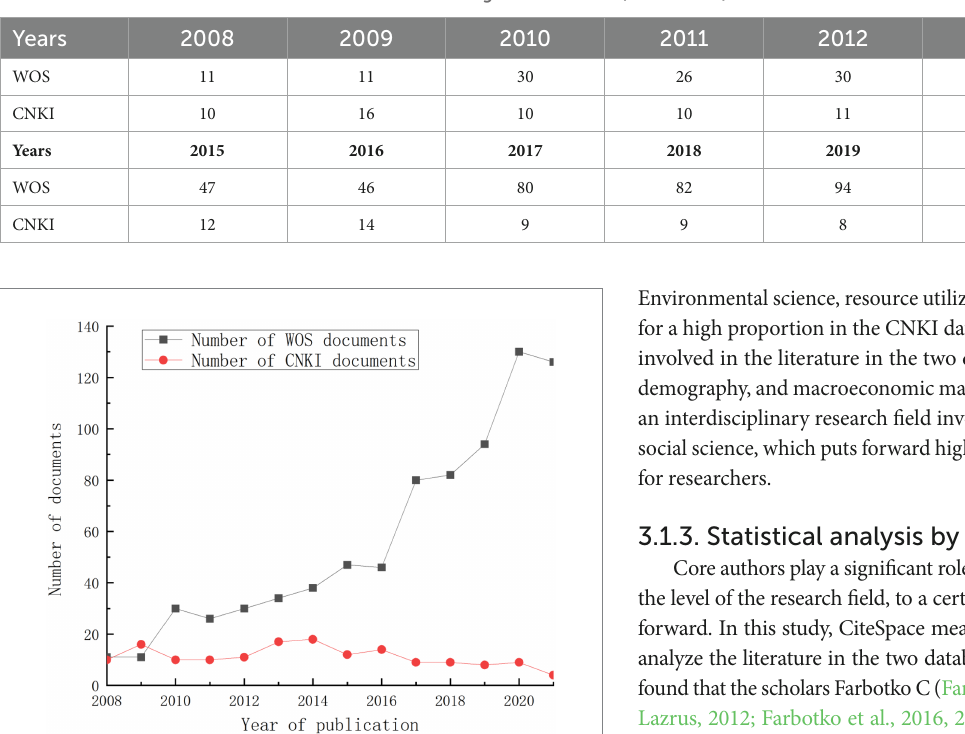
TABLE 1 Annual statistics of literature related to climate migration research